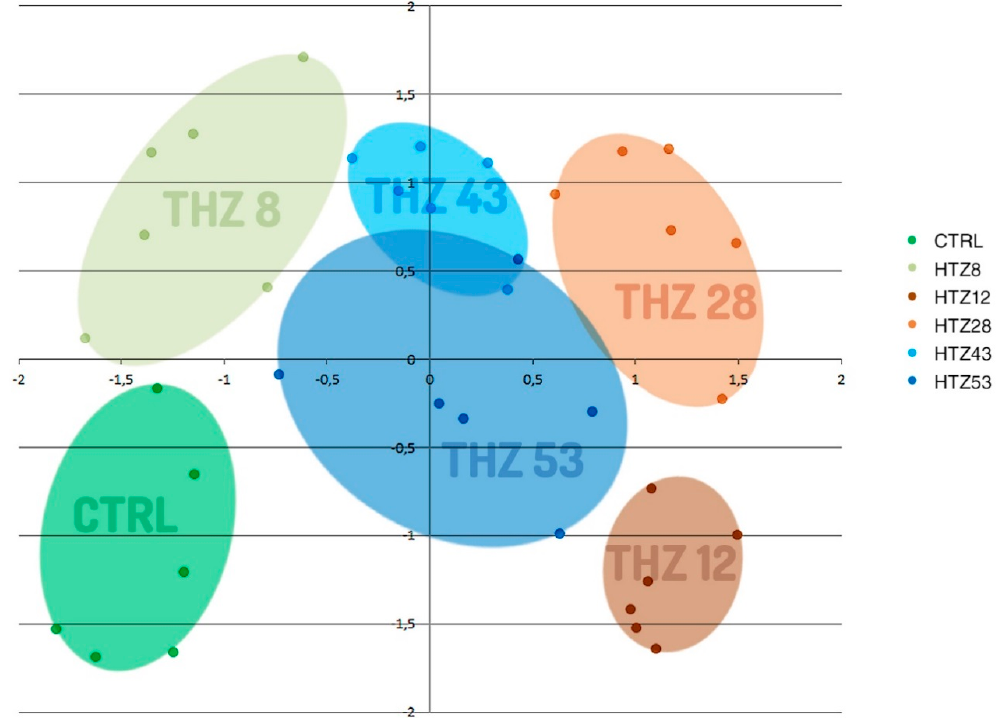
Figure 2. Independent Component Analysis of data obtained from Gas Chromatography–Mass Spectrometry (GC–MS) analysis of transgenic HTZ lines (HTZ8, HTZ12, HTZ28, HTZ43, HTZ53) and the control (CTRL). Colored areas cover agglomerations of the same sample’s data points.